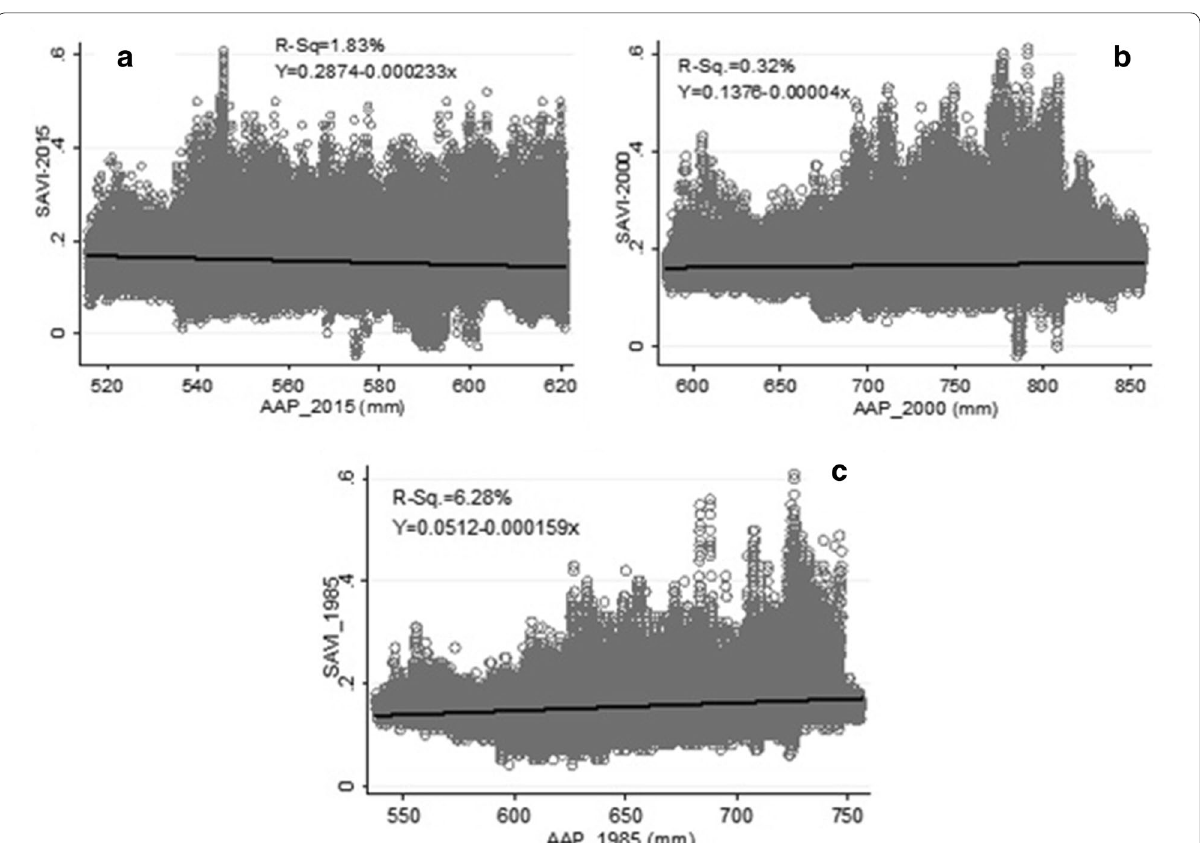
Fig. 11 Scatter plot of linear regression model between SAVI and AAP in 1985, 2000 and 2000 pixel-by-pixel. a regression plot of SAVI 2015 and AAP 2015; b regression plot of SAVI 2000 and AAP 2000; and c regression plot of SAVI 1985 and AAP 1985 (all